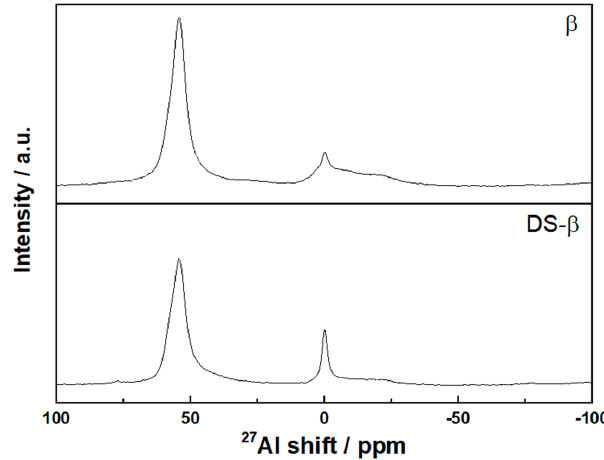
Figure 3. 27 Al magic angle spinning–nuclear magnetic resonance ( 27 Al MAS-NMR) spectra of β and DS- β .